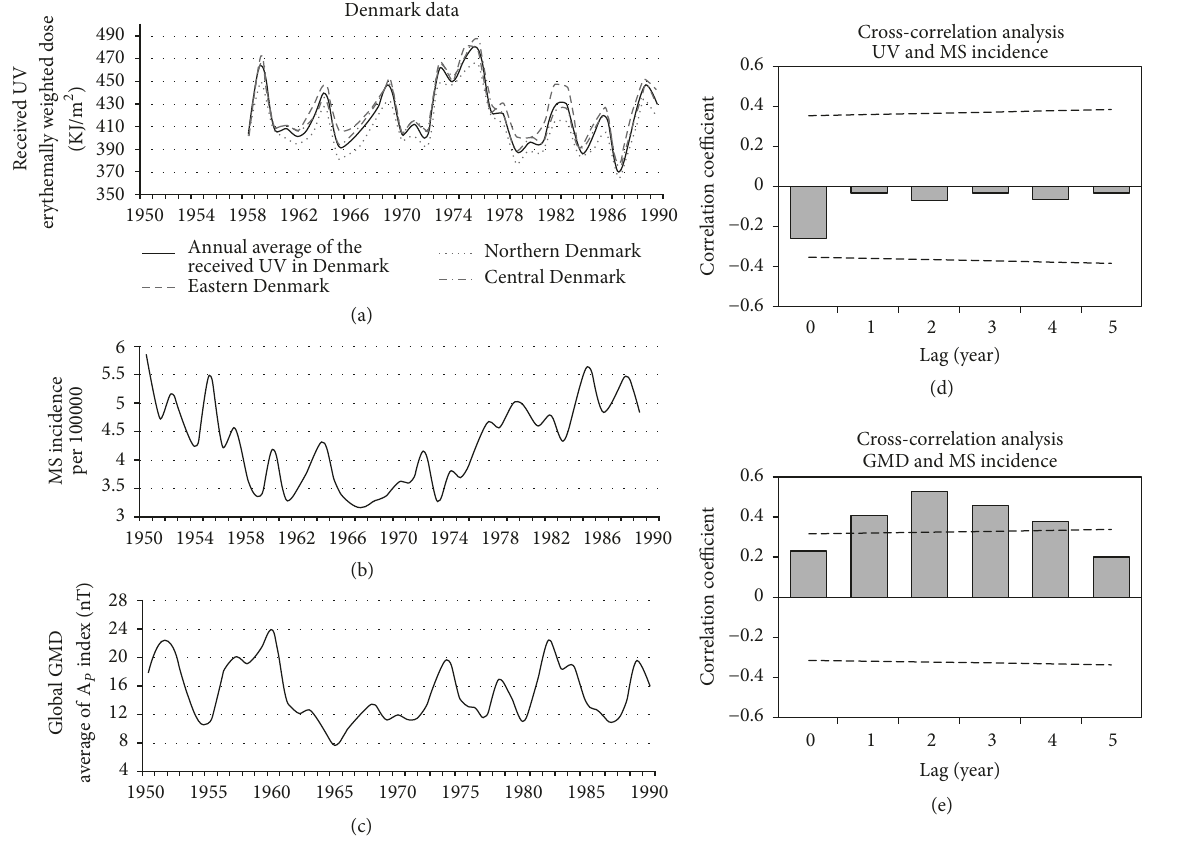
Figure 7: Denmark data. Panel (a): the black line shows the annual average of the received UV (1958–89) calculated from the data of the three sites in the central, northern, and eastern parts of the country (bright gray lines). Panel (b): MS incidence of the Denmark (1950–89), adapted from the report of Koch-Henriksen [16]. Panel (c): annual average of the global GMD based on the 𝐴 𝑝 index (1950–89). Panel (d): the result of the lagged correlation between received UV and MS incidence. Panel (e): the result of the lagged correlation between GMD and MS incidence. The dashed lines in panels (d and e) are the threshold for significant correlation. The horizontal solid lines in these panels indicate coefficient of correlation (𝑟) = 0